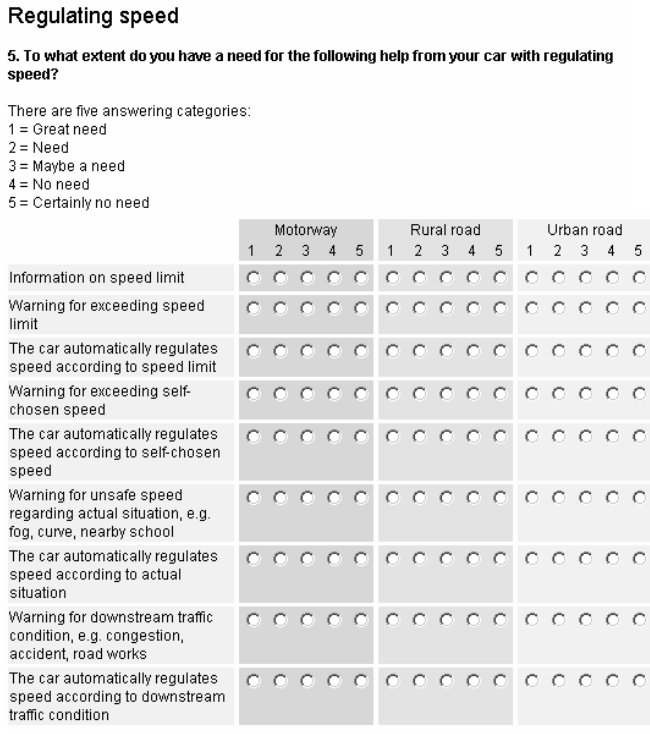
Figure 2. Example of a survey question: speed